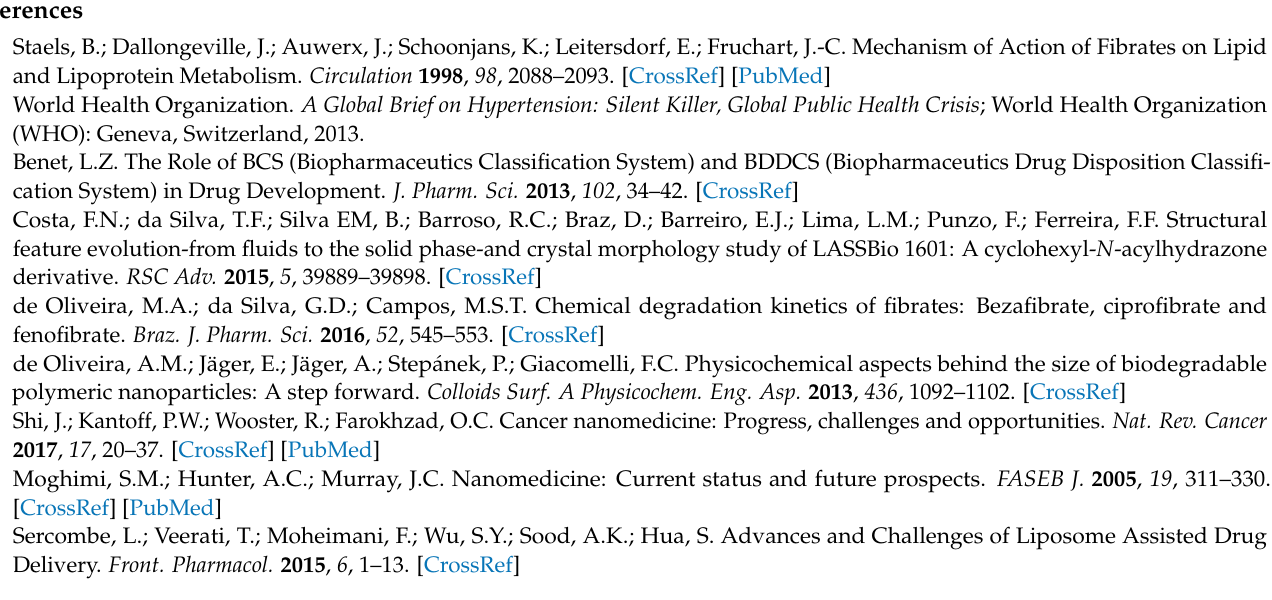
structure; Table S2: Bond lengths; Table S3: All angles; Table S4: Torsion angle data; Table S5: Spherical shell data fits; Table S6: Long cylinder fit for Pluronic + 20CIP; Table S7: Radius of gyration and D max (maximum particle dimensions) calculated using the ATSAS